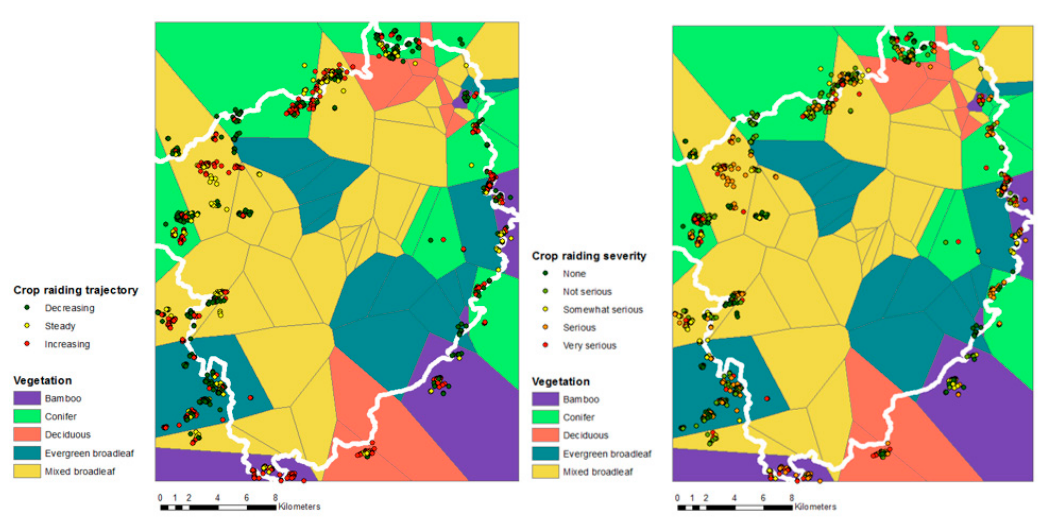
Figure 5. Perceived seriousness and trajectory of crop raiding.